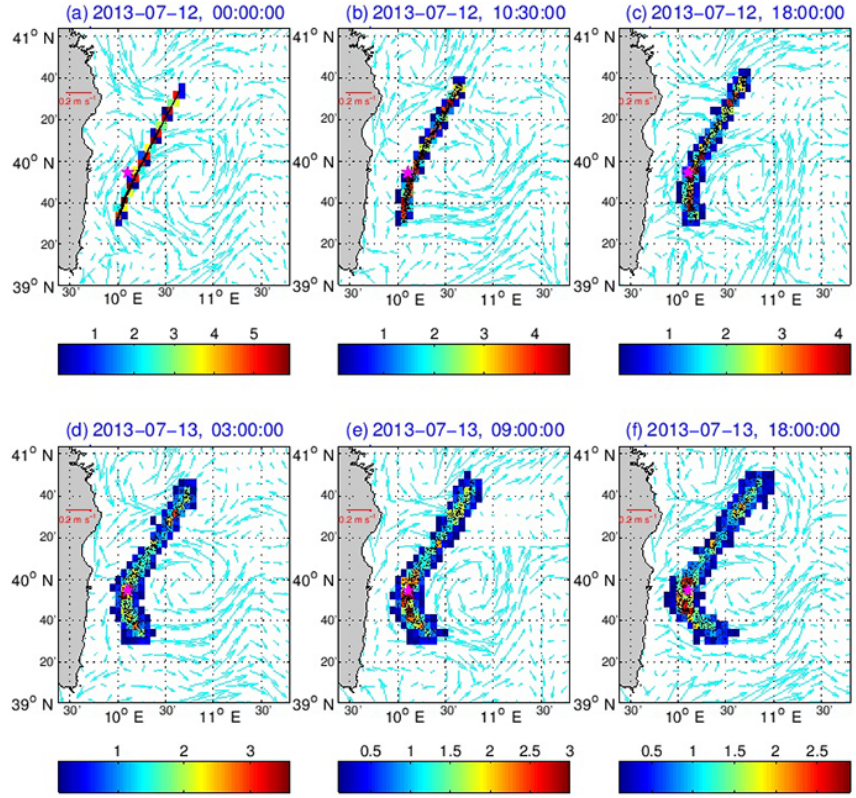
Figure 3. Particles’ cloud estimated by the LEEWAY model overlapped on the hydrodynamic field. Here the leeway is calculated by statistical law as in Breivik and Allen (2008) (green line in Fig. 5). The probability of containment (POC) is also computed, and it varies from blue/minimum to red/maximum value in each grid box of 0.6 × 0.6 ◦ . At rescue time (b) , the target (magenta point) is outside the particles’ cloud; it will be included in the cloud only 7.5h later (c)